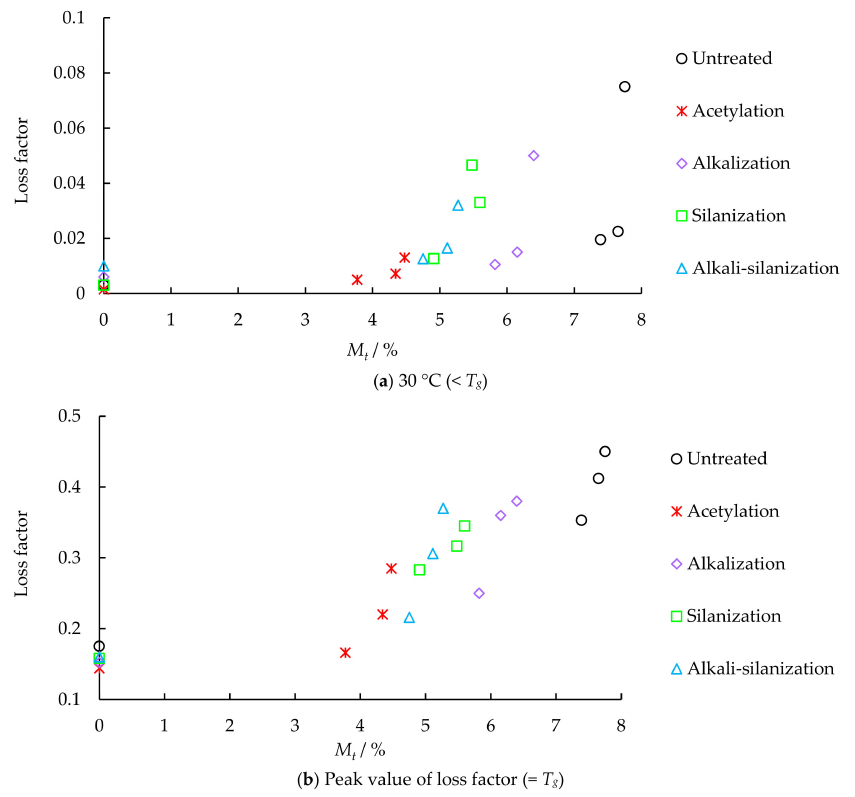
Figure 4. Relationship between storage modulus and moisture content.